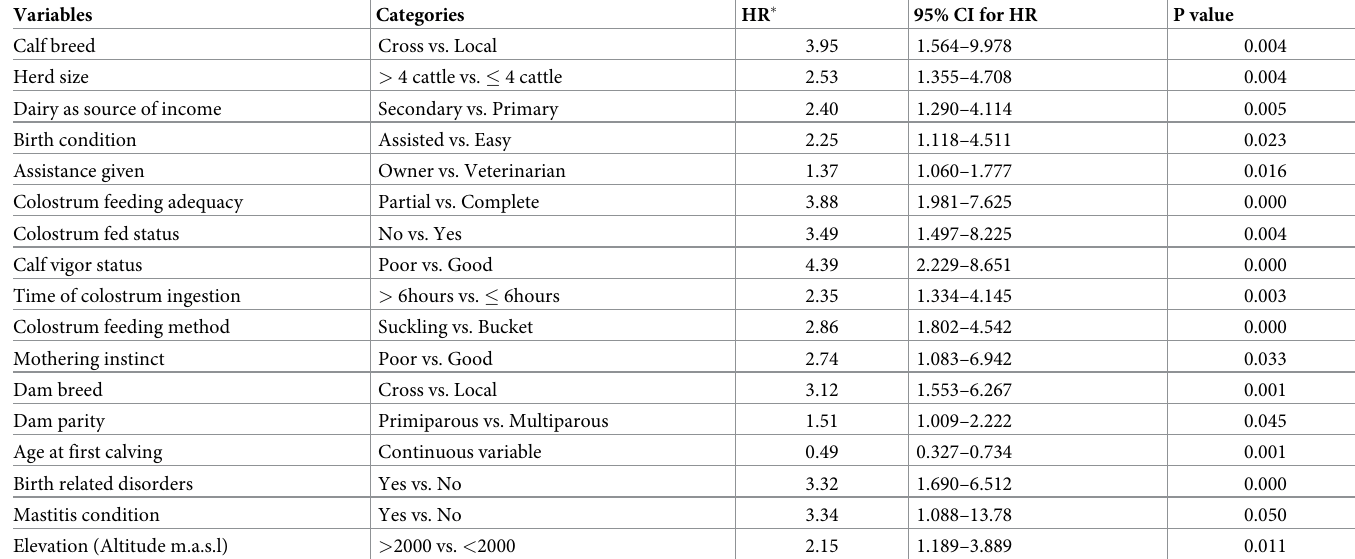
Table 6. Potential determinants significantly associated with incidence of crude morbidity based on univariate analysis using Cox